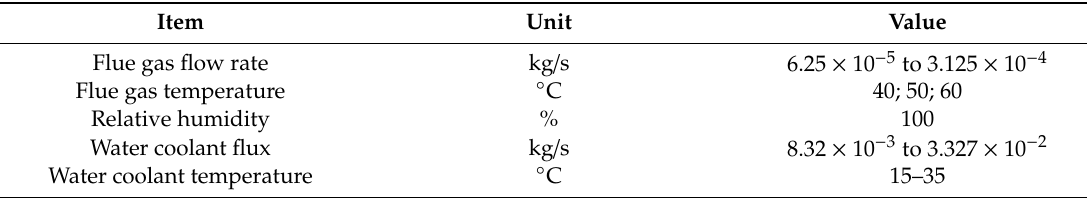
Table 1. Experimental operational parameters.